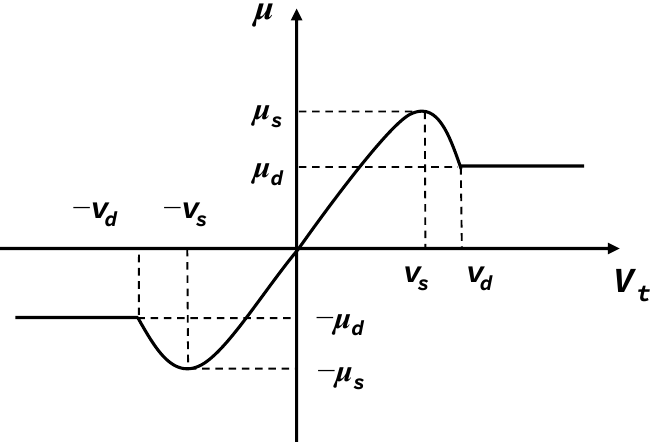
Figure 4. The evolution of tangential friction coefficient with relative velocity.